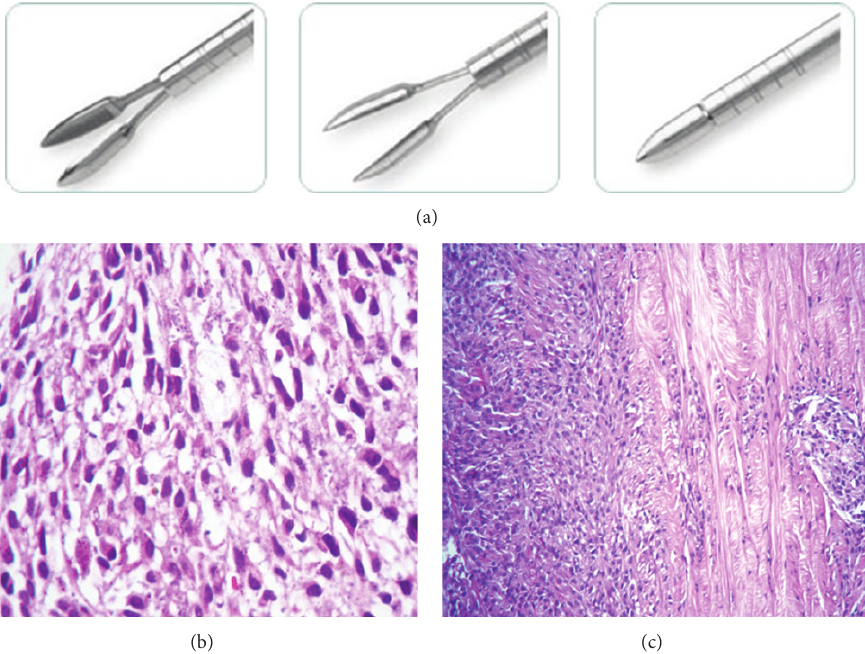
Figure 2: (a) Picture showing the new Essen biopsy forceps. (b) Biopsy of the right eye, using the Essen biopsy forceps. The specimen obtained measures 1 × 1mm, and histopathological section shows a small fragment of neoplastic tissue formed by conglomeration of cells withacidophiliccytoplasmwithpoorlydefinedandatypicalnucleiwithdensechromatin,sometimespolarized.Somecellscontainingmelanin pigment. (c) Histopathology of enucleation showing a 14 × 13mm choroid melanoma with areas of recent